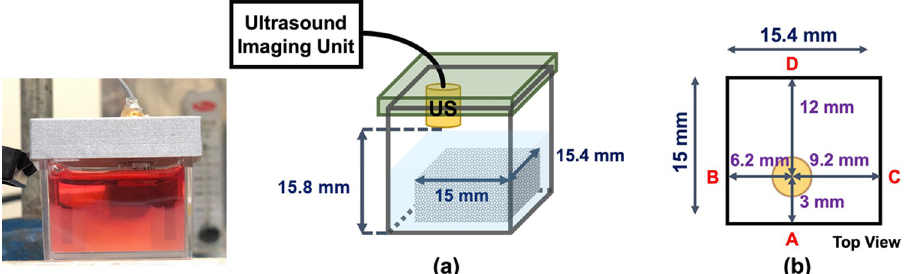
Fig 1. (a) Schematic of the single-element transducer ultrasound shear wave elasticity measurement system. (b) illustration of the position of the ultrasound transducer (US) relative to the side boundaries of the